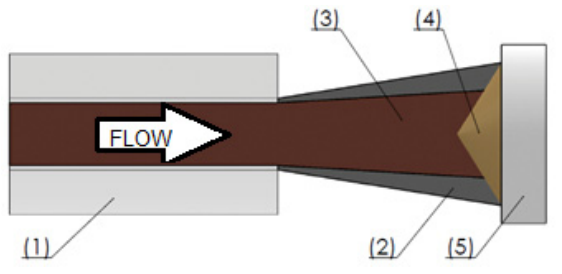
Figure 6. Scheme of CS particles laden jet. (1) Nozzle, (2) sparse particles and lower velocity particles laden jet, (3) concentrated particles and high-velocity particles laden jet, (4) sprayed material, (5) flat substrate.